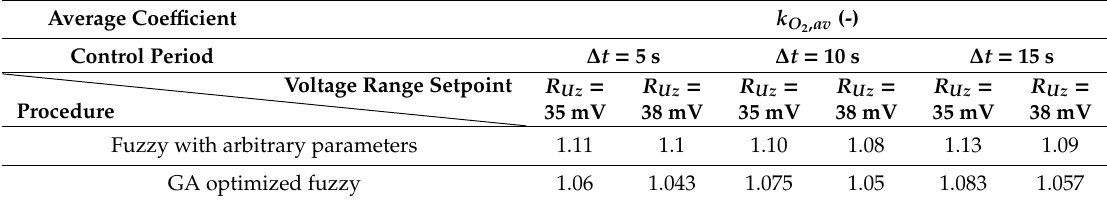
Table 9. Comparison of the results of the procedure of determining flow rate of oxygen obtained in